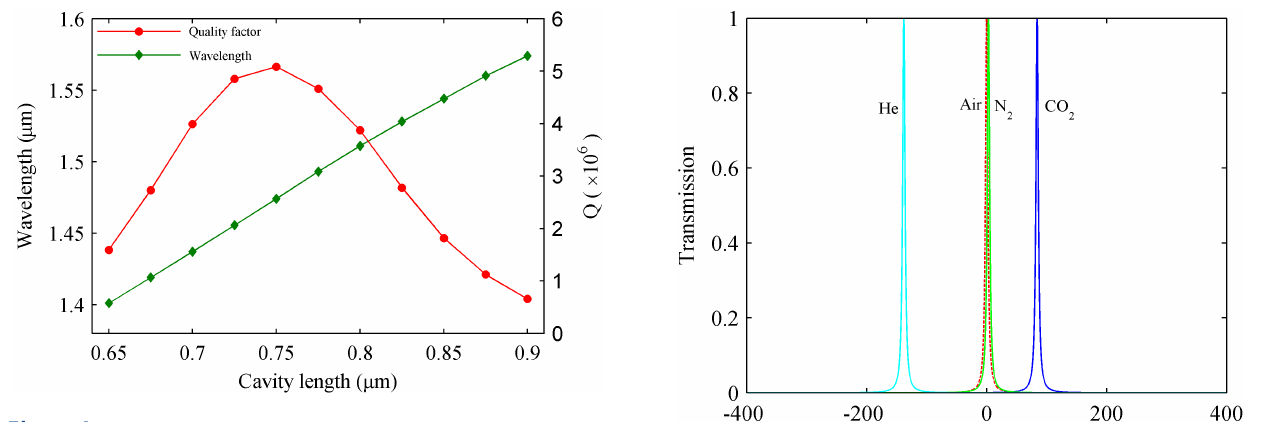
Figure 4. The cavity wavelength and quality factor as a function of cavity length for d Si = 0 . 52µm and d Air = 0 . 42µm.